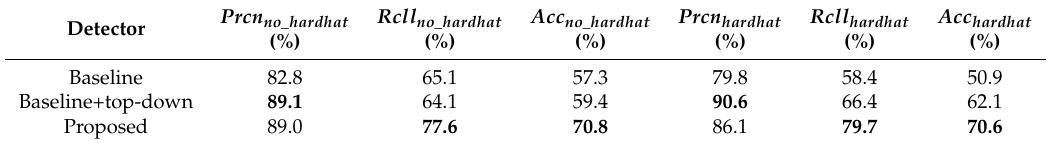
Table 4. Results comparison of different network architectures under the occlusion condition (bold indicates either best performance or minimum cost).